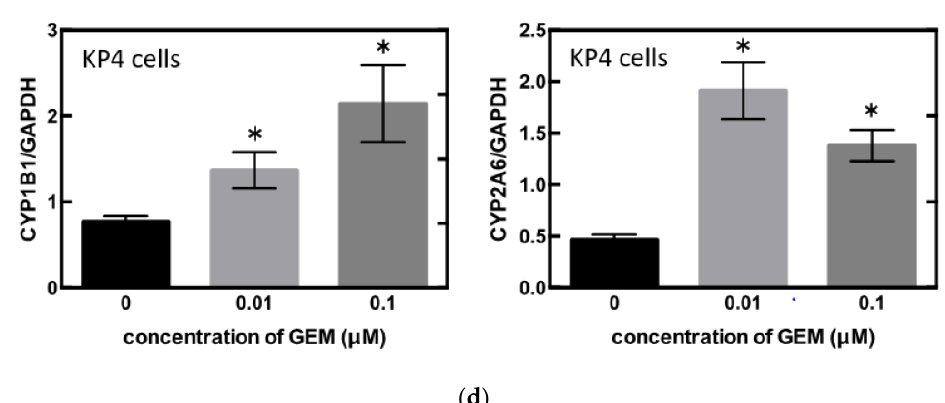
Figure 3. ( a ) MiaPaCa-2 cells were treated with gemcitabine (GEM) 0–1 µM for 48 h, and the cell number was counted. ( b ) MiaPaCa-2 cells were treated with GEM, and after 48 h, RNA was extracted from the cells, and qPCR was performed using CYP1B1 or CYP2A6 primers. ( c ) KP4 cells were treated with GEM 0–1 µM for 48 h, and the cell number was counted. ( d ) KP4 cells were treated GEM, and after 48 h, RNA was extracted from the cells, and qPCR was performed using CYP1B1 or CYP2A6 primers. All data are represented as mean ± SEM, n = 3. * p < 0.05. Ultimately, we treated the MiaPaCa-2 cells with the CYP1B1 inhibitor, alizarin, which